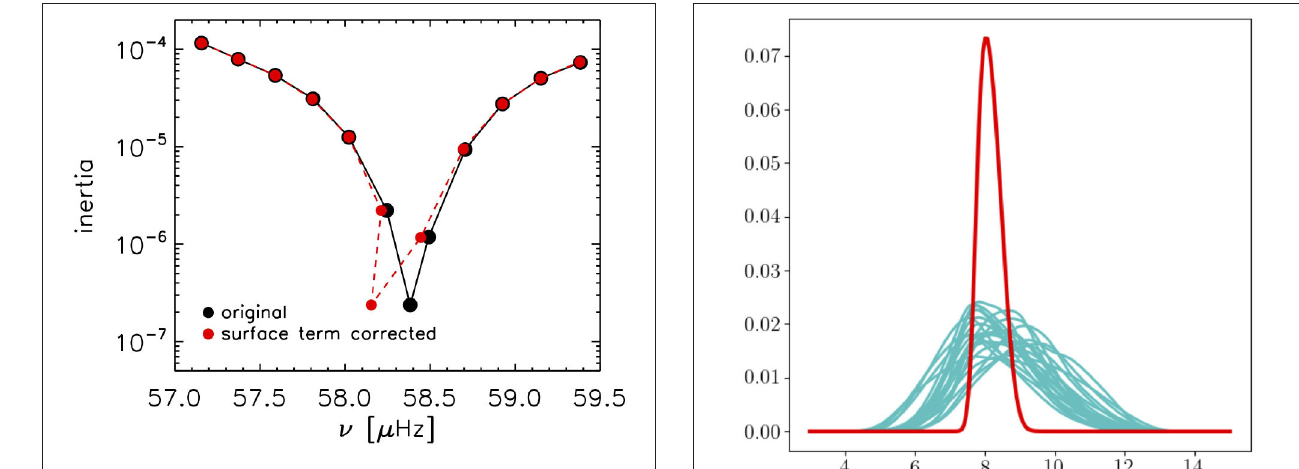
FIGURE 9 | The effects of the Ball and Gizon (2014) surface-term correction on l 1 modes of red-giant models. Note that the most p-dominated mode = shifts enough to confuse its frequency with the more g-dominated mode at lower frequency. Data are from Ball et al. (2018).